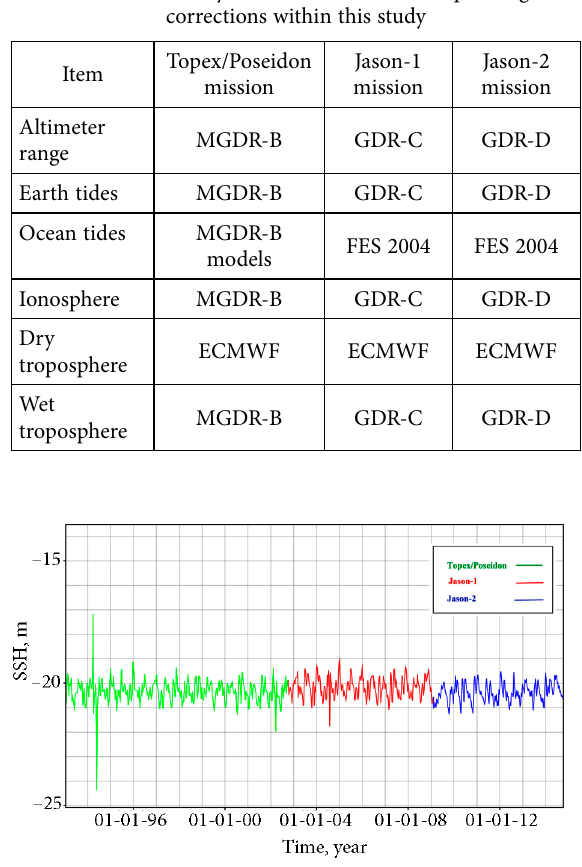
Table 2. Altimetry datasets and their corresponding